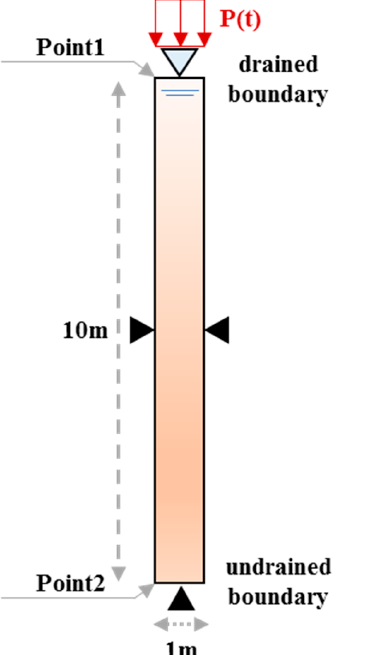
Figure 1. Geometry and boundary conditions of a fully saturated soil column. Table 1. Soil properties of the fully saturated soil column.